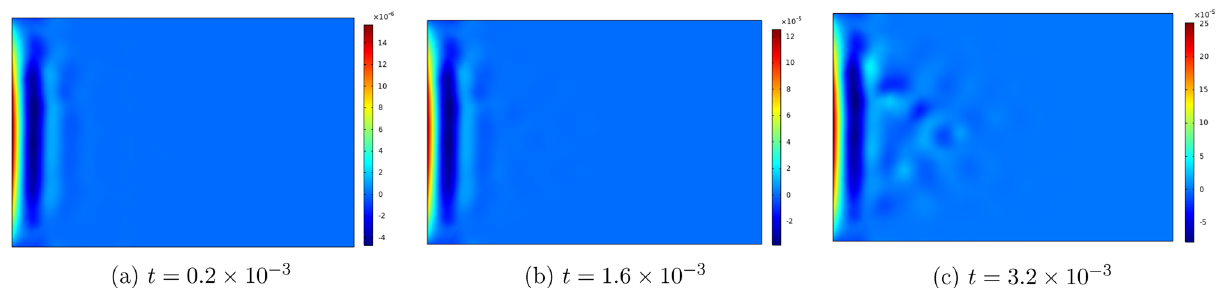
Figure 6. Top view of the temperature distribution in the slab at three consecutive time